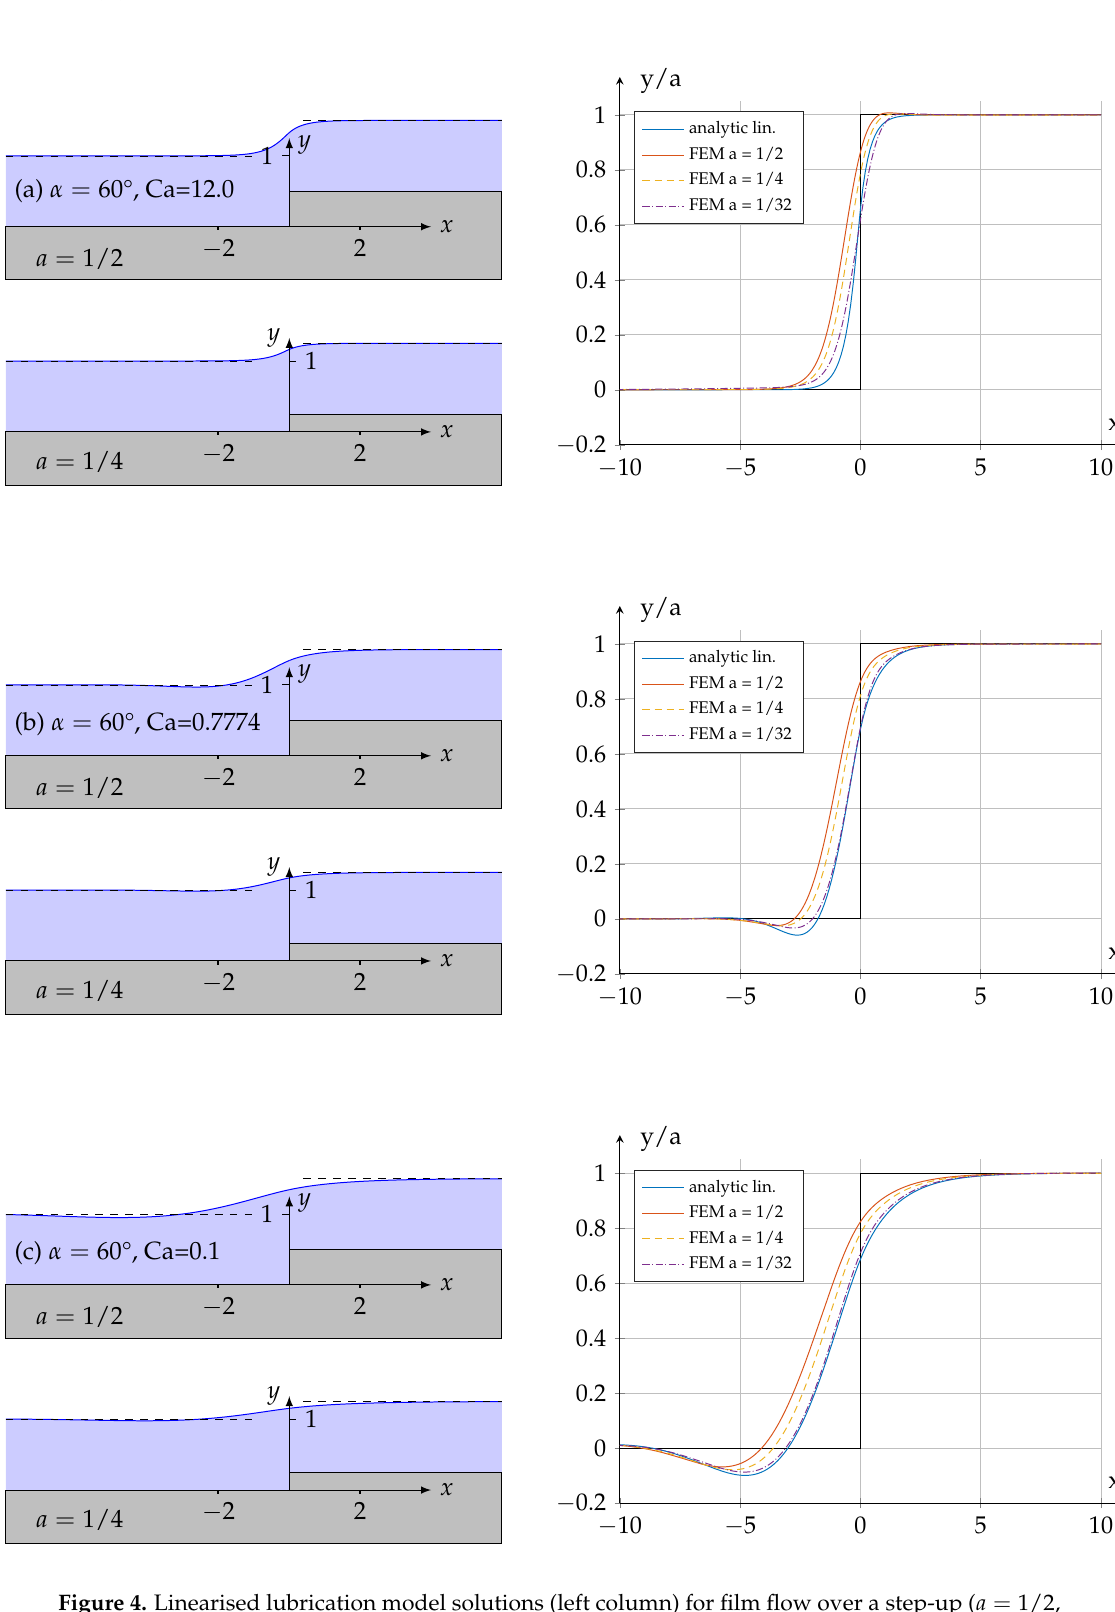
Figure 4. Linearised lubrication model solutions (left column) for film flow over a step-up ( a = 1/2, 1/4 and 1/32 for different values of Ca (12.0 (top), 0.7774 (middle), 0.1 (bottom)) and α = 60°) showing the predicted free surface disturbance (blue curve), compared with FE solutions of the first integral equations (right column; using a different scaling for clarity): ( a ) monotonic transition; ( b , c ) damped spatial oscillations upstream. The flow is from left to right, the dashed lines in the left-hand column indicating the unperturbed film thickness on the upstream and downstream sides of the